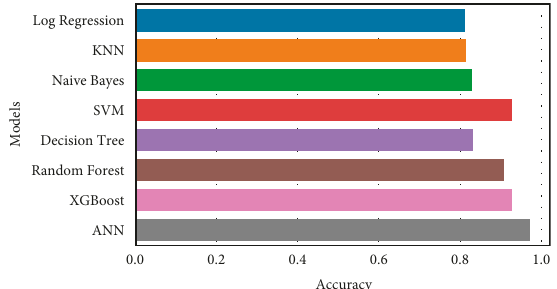
Figure 7: Comparative analysis of accuracy using different prediction